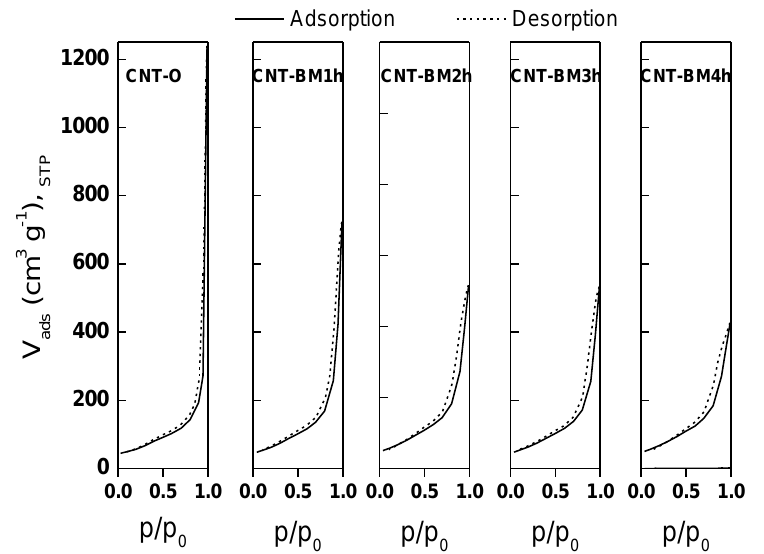
Figure 1. N 2 adsorption–desorption isotherms at − 196 ◦ C for pristine and modified carbon nanotubes (CNTs).